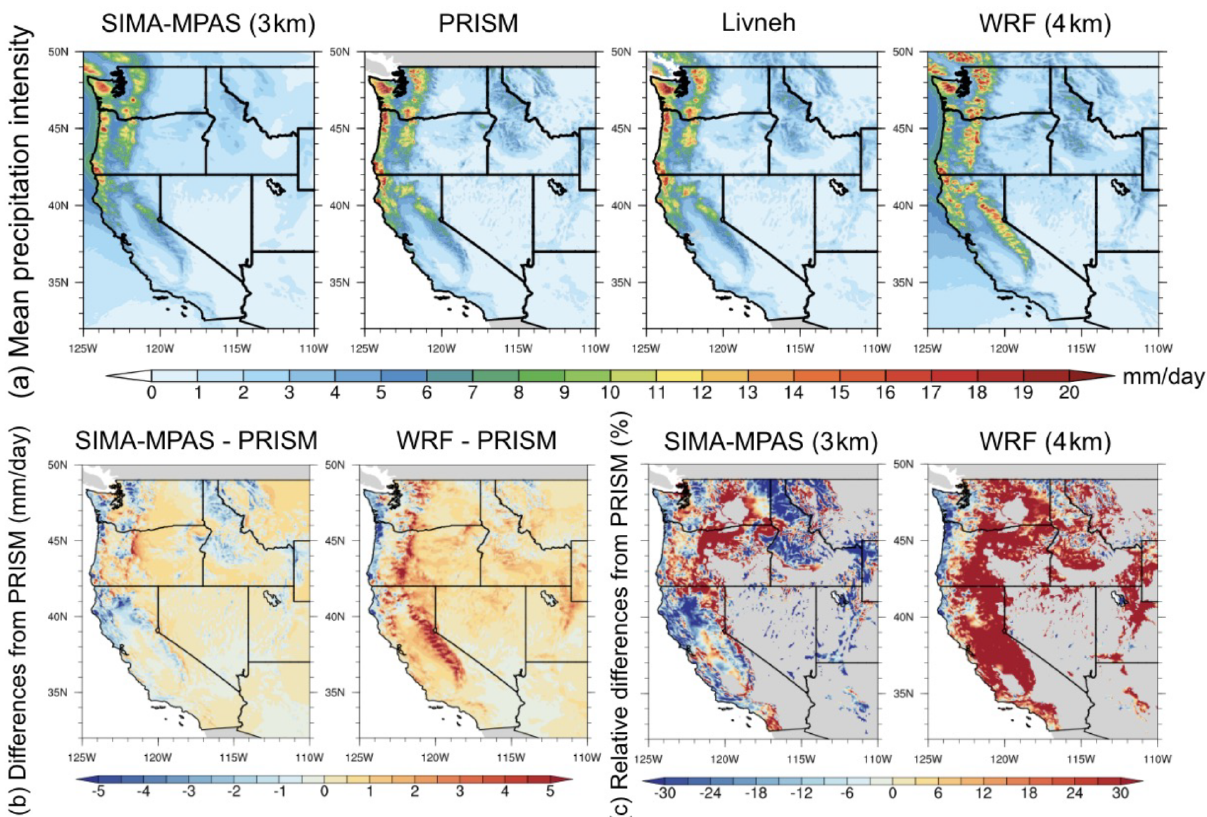
Figure 4. Mean simulated precipitation and differences from observation: (a) wet-season (mid-November to mid-March) daily precipitation intensity over the western USA (1999–2004); (b) absolute differences from PRISM reference; (c) similar to (b) but for relative differences from PRISM (grid box values of less than 1mmd − 1 have been masked) with the SIMA-MPAS model data regridded to the same resolution as the PRISM grid spacings (i.e.,